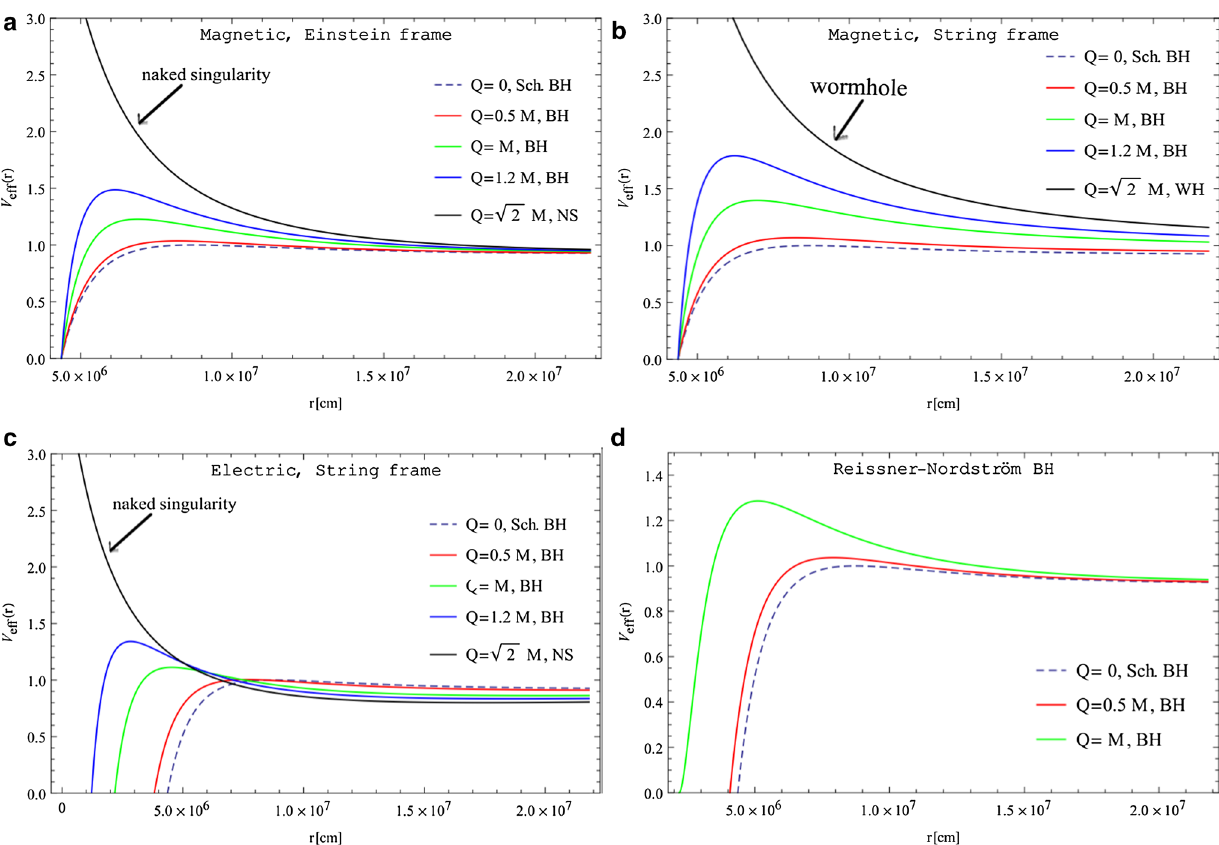
Reissner–Nordström and Schwarzschild BH ( d ). At the extreme limit, √ Q = 2 M , the potential diverges at the NS radii ( a , c ) and at the WH throat ( b ). The potential coincides with that of the Schwarzschild